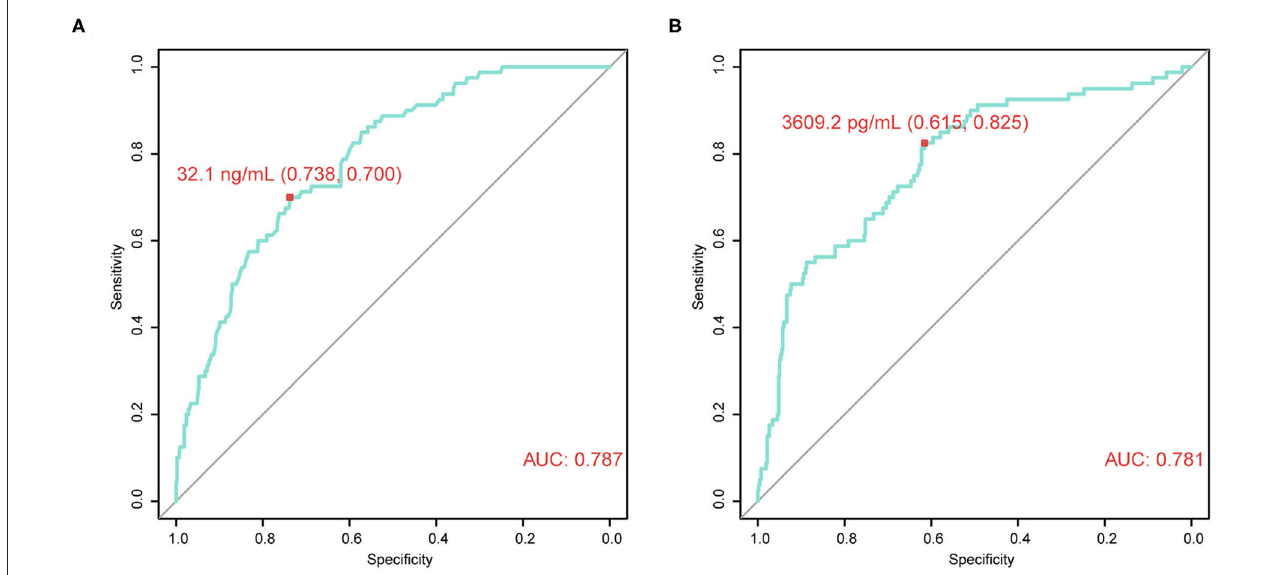
FIGURE 2 | Time-dependent receiver operating characteristic (tdROC) curves reveal good predictive effect and determine optimal cut-off values of cysteine rich secretory protein 3 (CRISP3) and serine peptidase inhibitor Kazal type 1 (SPINK1). (A) CRISP3 tdROC curve indicates that the optimal cut-off value is 32.1ng/ml (sensitivity: 73.8%; specificity: 70.0%). (B) SPINK1 tdROC curve indicates that the optimal cut-off value is 3609.2 pg/ml (sensitivity: 61.5%; specificity: 82.5%).